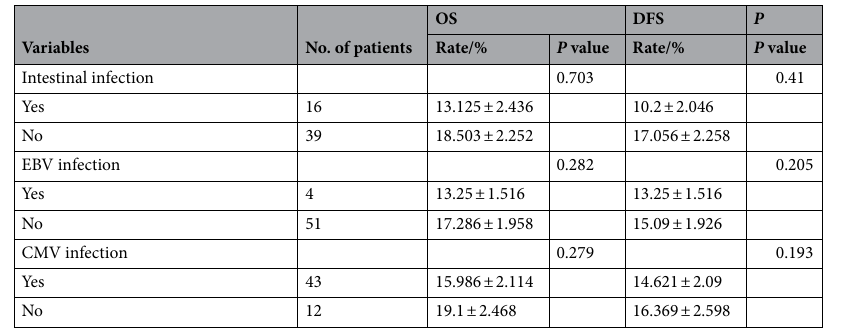
Table 3. Univariate survival analysis of OS and DFS after allo-HSCT ( x ± s ) ( N = 55).